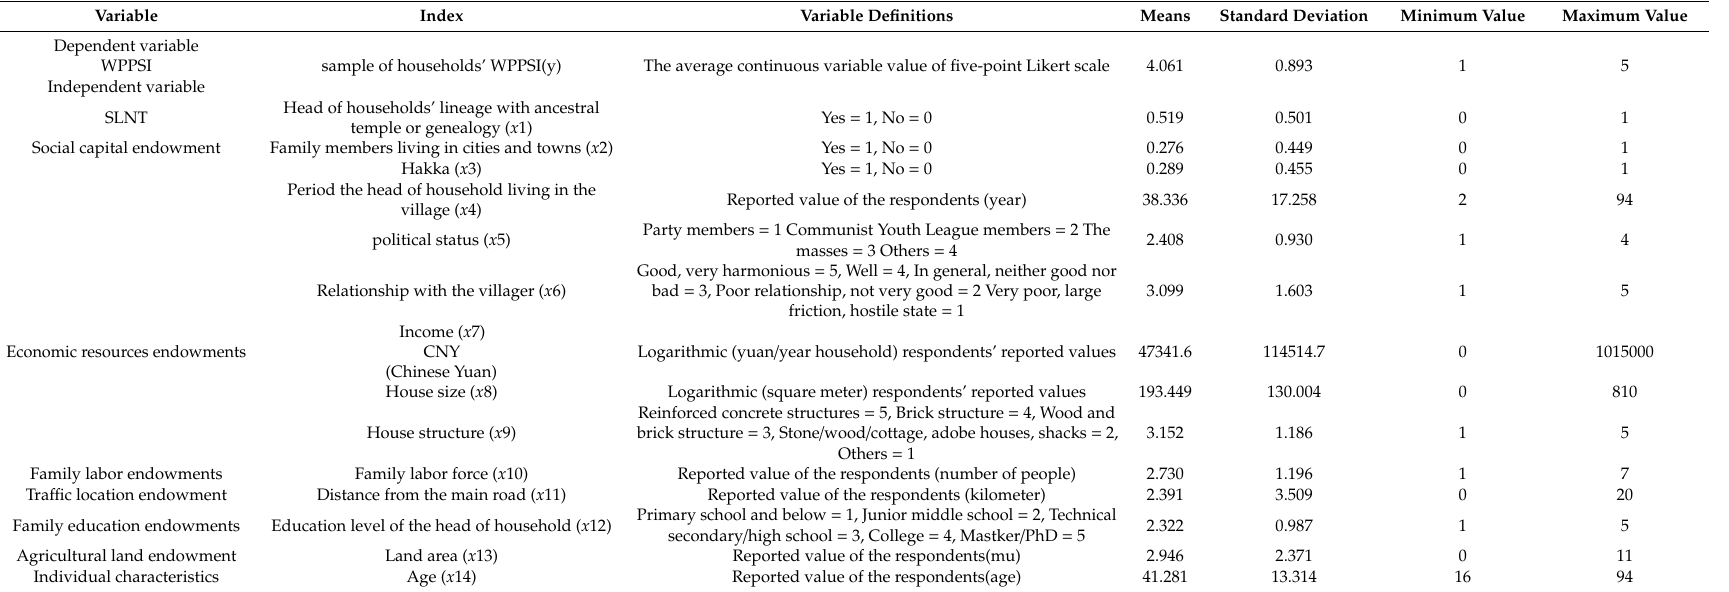
Table 3. Variables definitions and